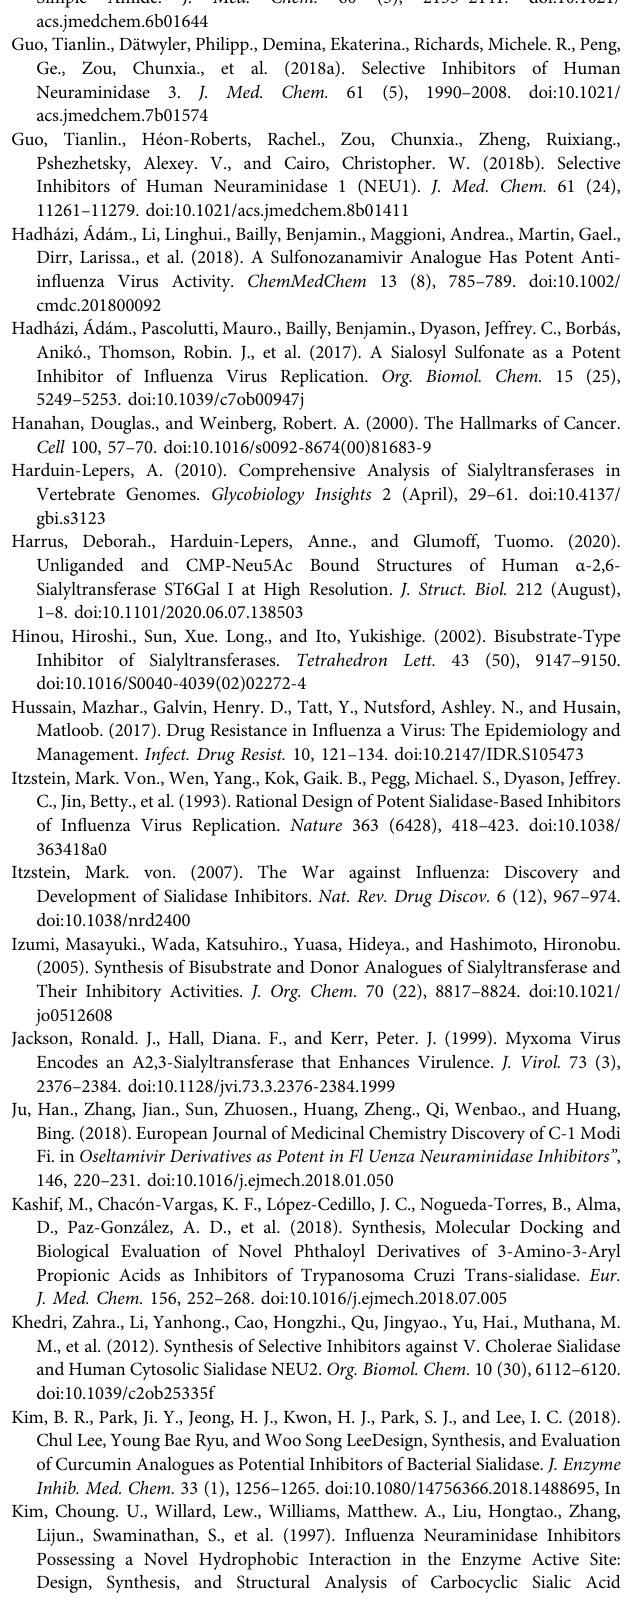
Figueredo, Andreza. S., De Andrade, Peterson., Riul, Thalita. B., MarchioriThais Canassa De Leo, Marcelo. F., Fleuri, Anna. Karoline. A., Schenkman,